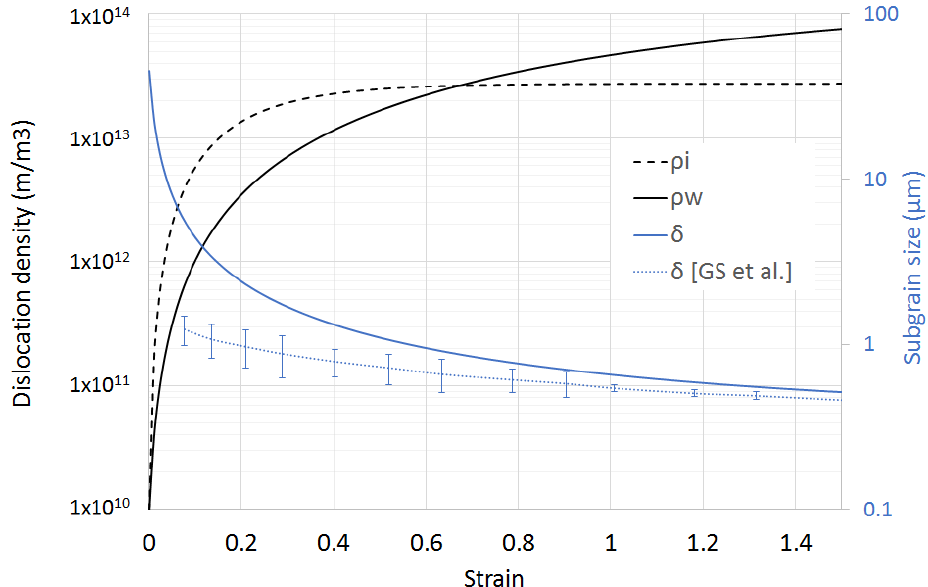
Figure 5. Modelled dislocation densities and subgrain size developed during deformation at room temperature and 10 s − 1 of strain rate. Experimental data from Reference [25] show good correlation with the literature.